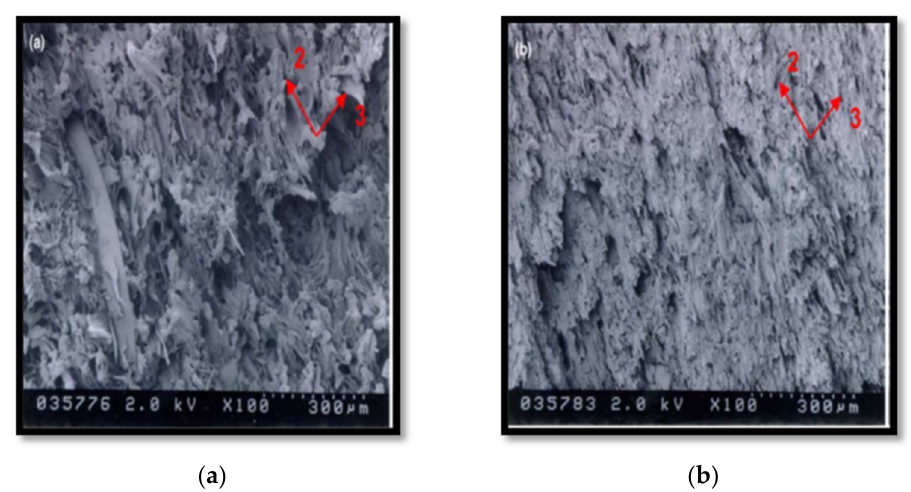
Figure 6. ( A,B ) keratin feather fiber in LD133A LDPE. Reprinted/adapted with permission from Ref. [53].